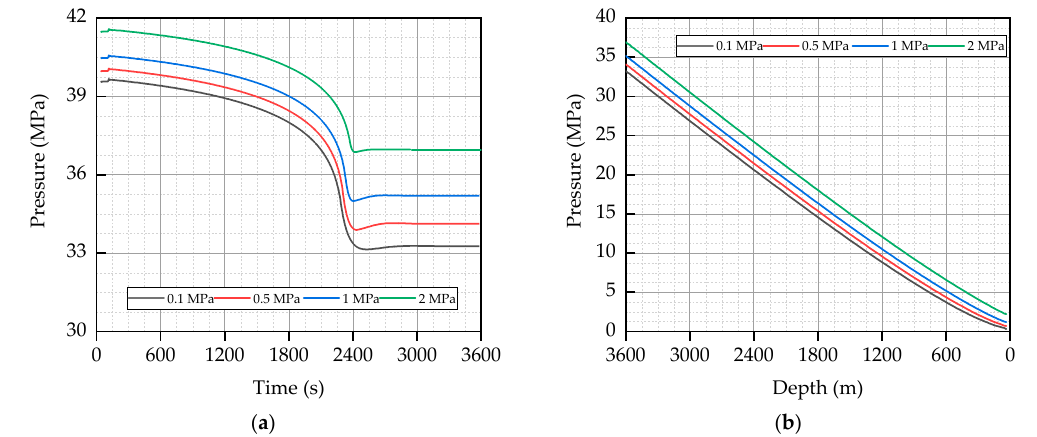
Figure 17. Variation in the bottom hole pressure under different back pressures at different: ( a ) times; and ( b ) depths.